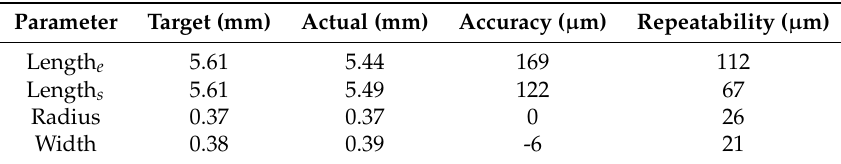
Table A1. Target, Accuracy, and Repeatability Values for a Printed Spiral FSS.